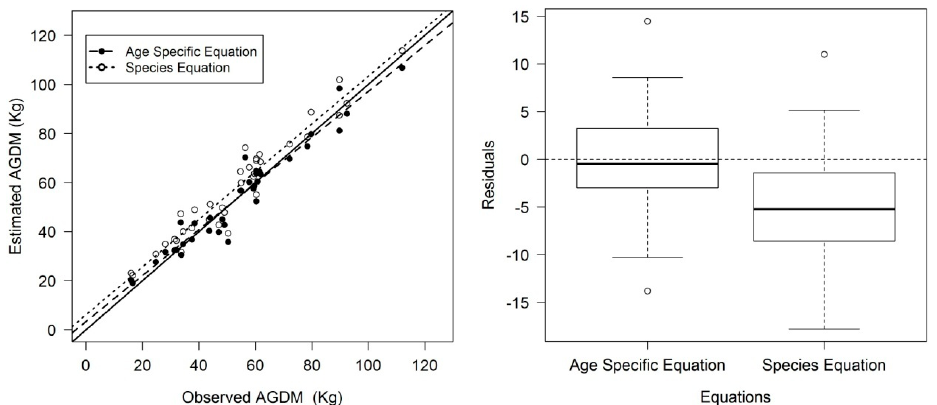
Figure 2. ( Left ) Comparison of allometric equations of above-ground dry mass (AGDM) using the estimated of “Species Equation” and “Age Specific Equation” for C 12 in relation to the observed values; ( Right ) Comparing the equations showing the differences between the residuals generated from “Species Equation” and “Age Specific Equation” for AGDM with deviations around the mean.